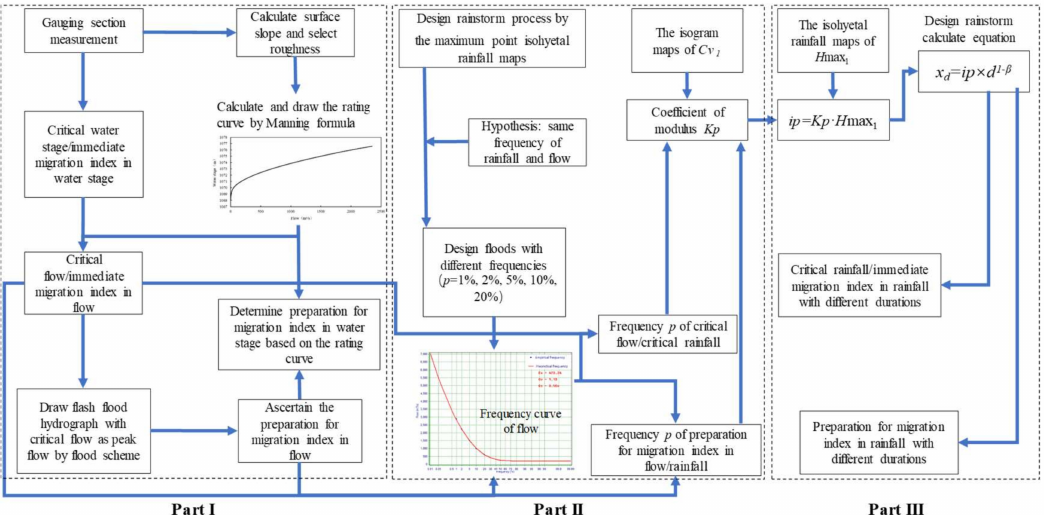
Figure 6. Flowchart of the early warning system for flash flood disasters, where d represents the duration; H max d represents the max point rainfall with different durations, mm; ip represents the rainfall threshold with one hour; Cv 1 represents the coefficient of variation of max point rainfall when d = 1; Kp represents the coefficient of modulus; x d represents the threshold of rainfall with different durations; β represents the rainstorm decline